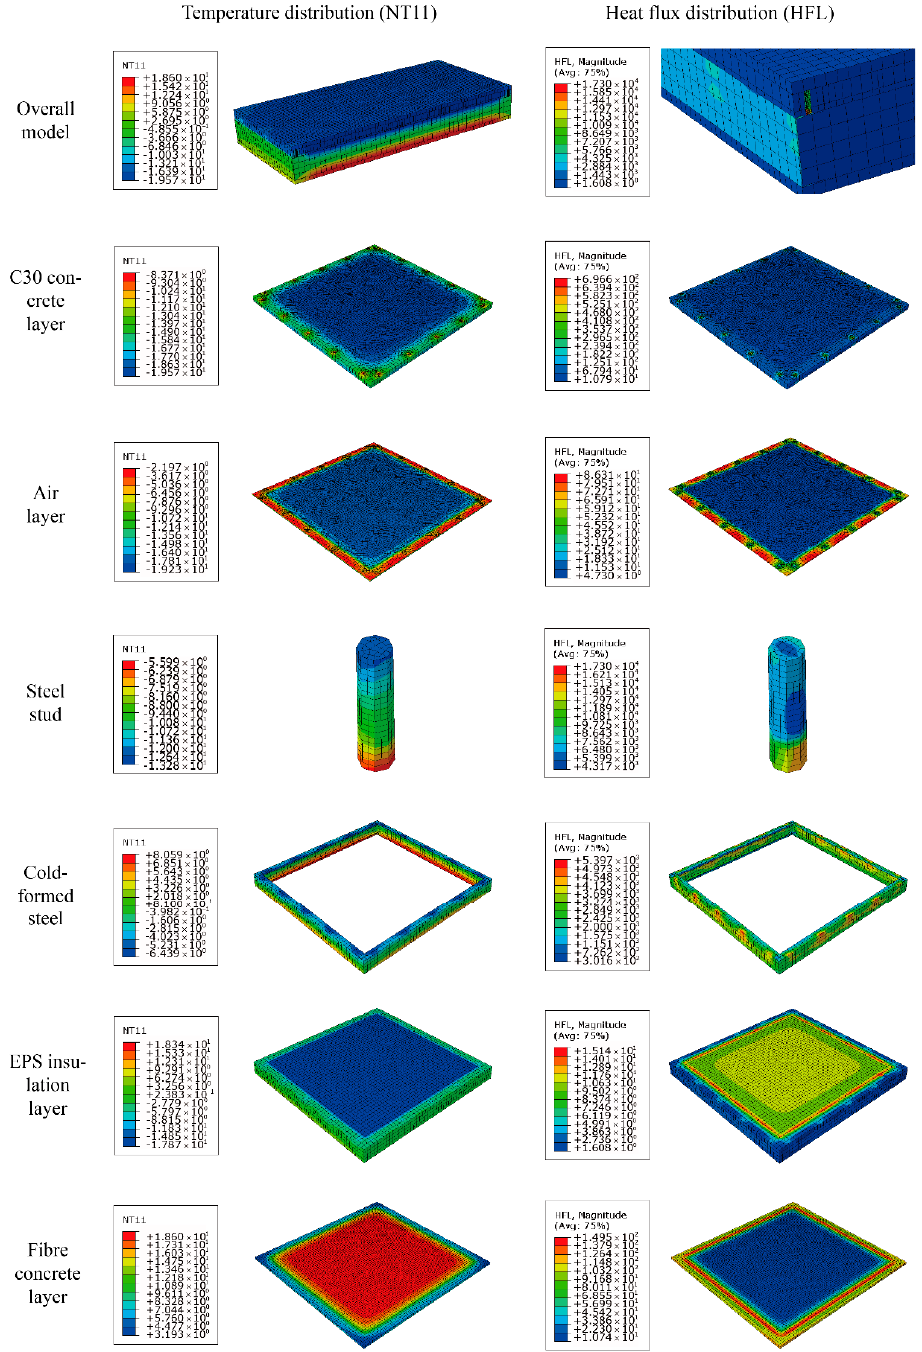
Figure 6. Temperature (°C) and heat flux (W·m − 2 ) distribution of NT11 and HFL of the LAEWP and all parts. culated. Because the total heat flow at any section perpendicular to the direction of heat flow is equal, the value of HFL3 will be taken as the actual heat flow rather than the HFL